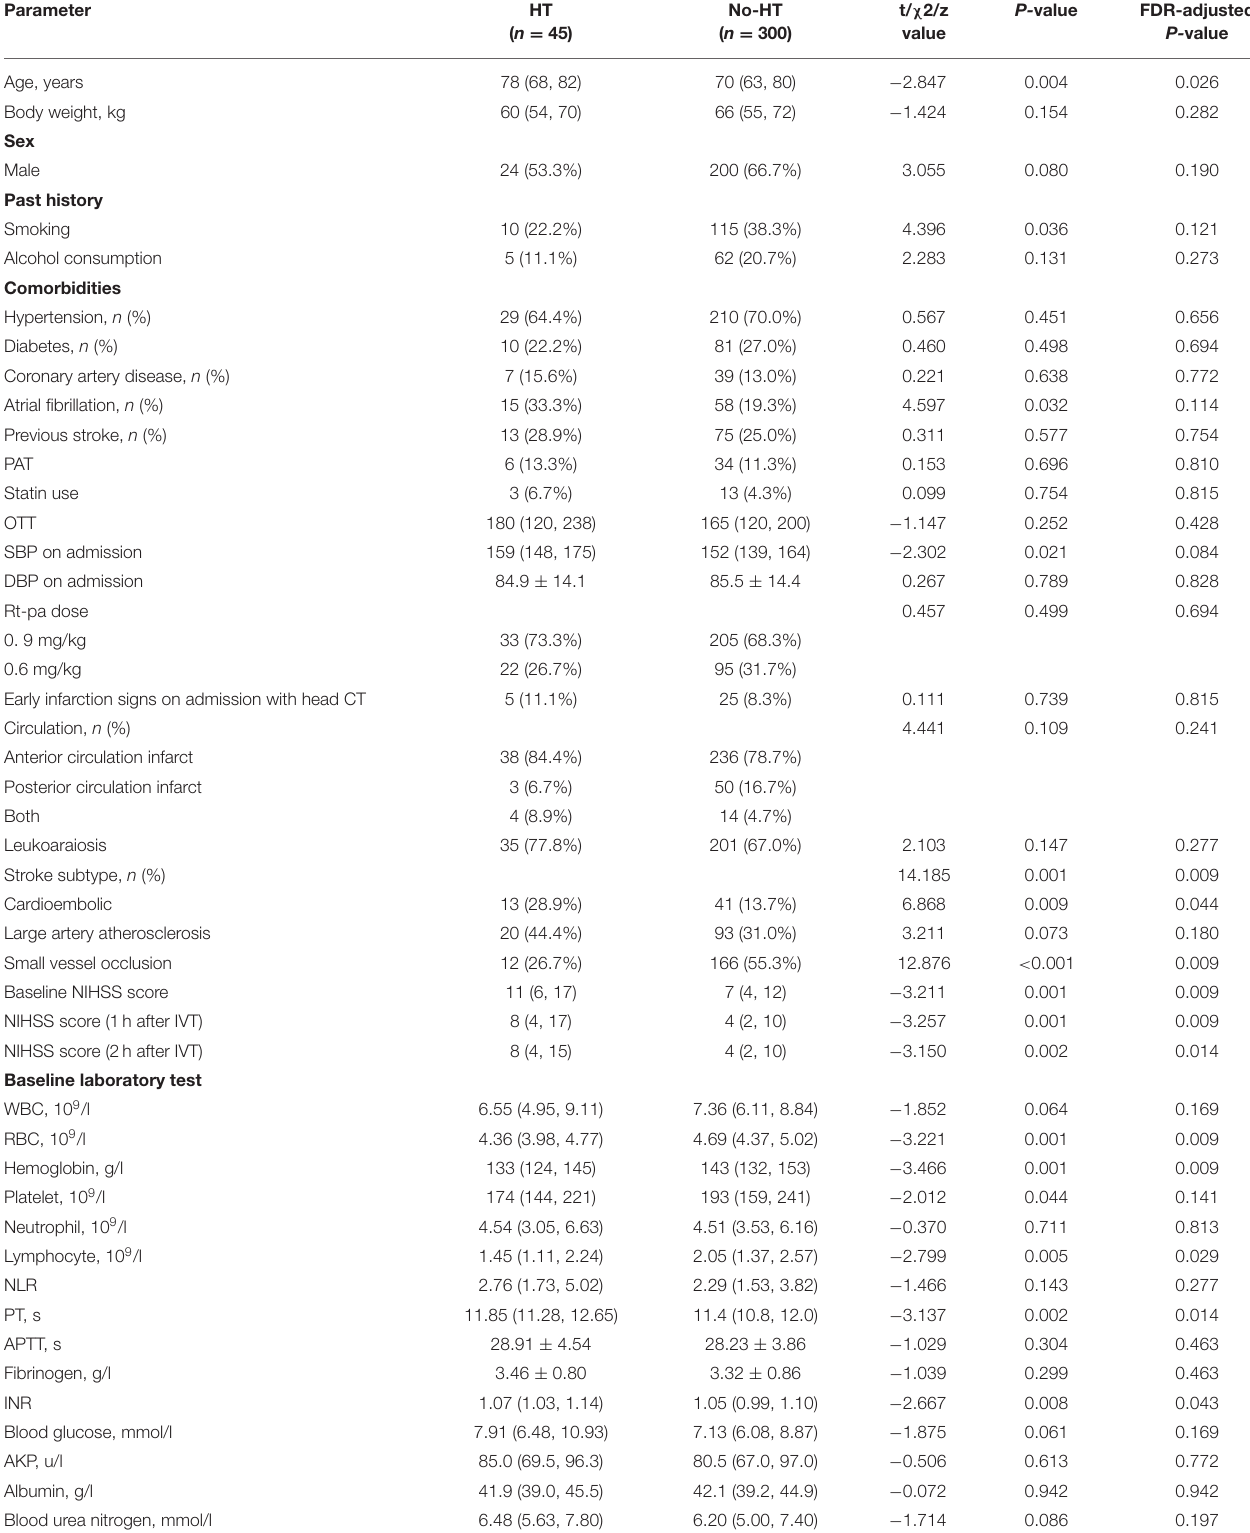
TABLE 1 | Demographic and clinical characteristics of the study sample.